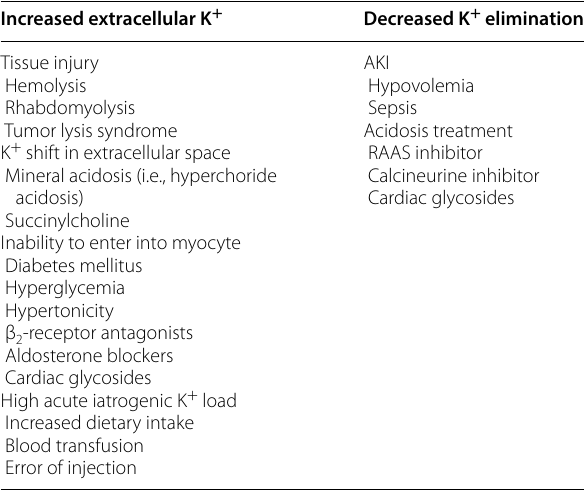
K + potassium, RAAS renin–angiotensin–aldosterone system